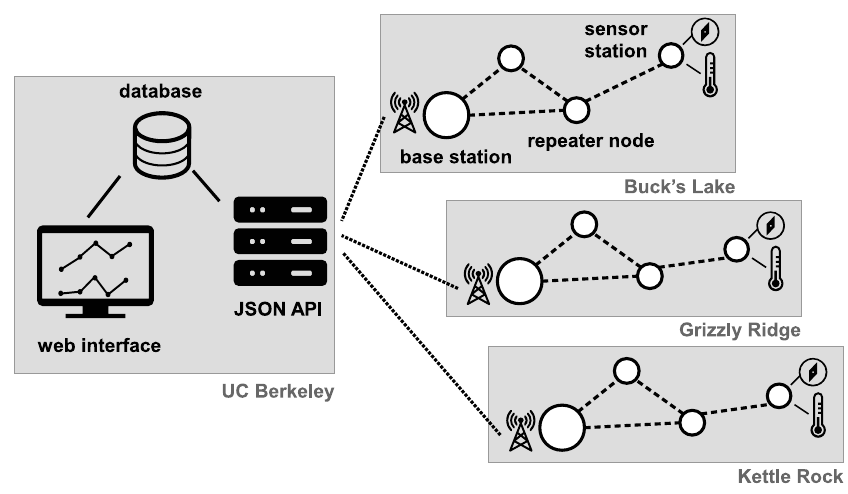
Figure 3. Software architecture (adapted from